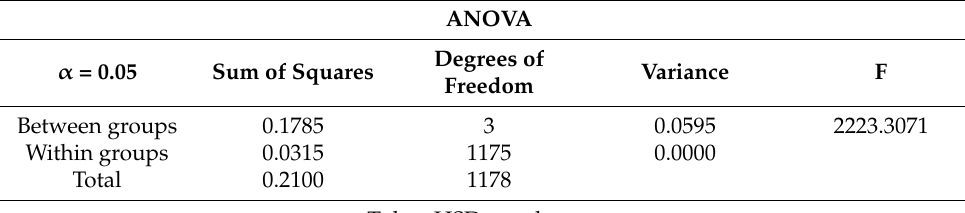
Table 11. Results of ANOVA with Tukey HSD post hoc test for HCHO at the measurement point 3.